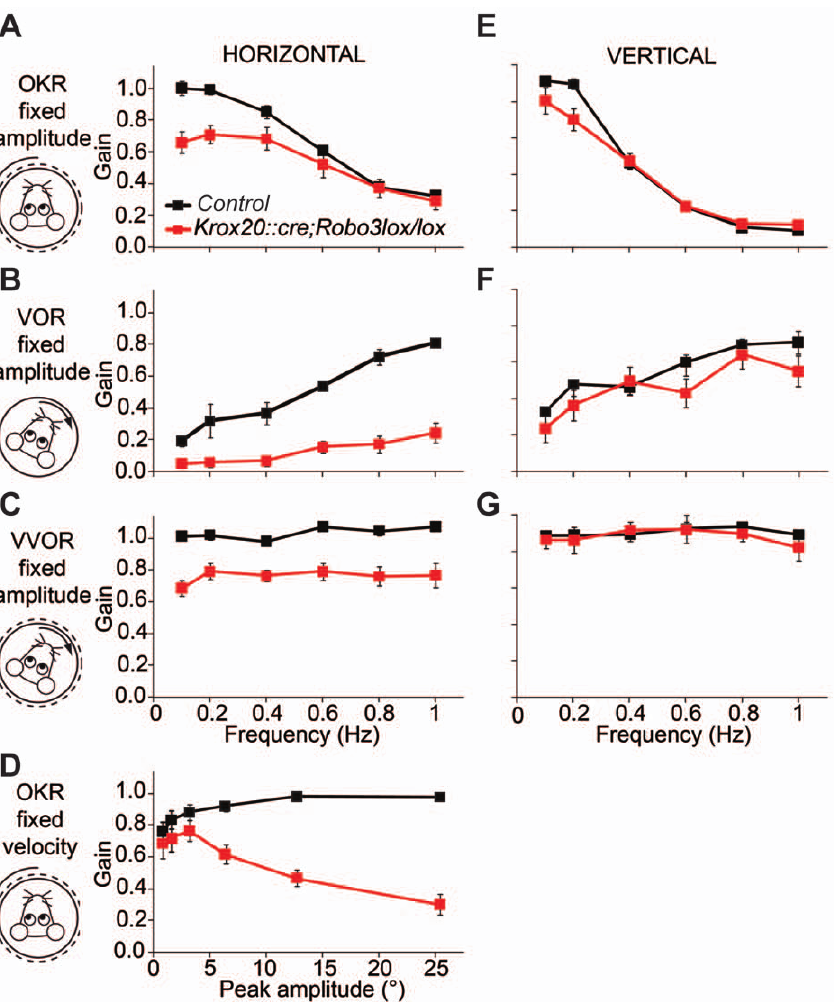
Figure 5. Impaired horizontal compensatory eye movements in Krox20::cre;Robo3 lox/lox mice. (A) During optokinetic stimulation horizontal gains are reduced most prominently at the lower frequencies in in Krox20::cre;Robo3 lox/lox mice ( p =0.043 ANOVA; n =6 versus n =4 for controls; see Table S1). (B) At higher frequencies, the VOR is severely impaired ( p =0.001 versus control mice curve; ANOVA for repeated measurements; Table S1), confirming the importance of the commissural connections in large-amplitude eye movements. (C) When horizontal visual and vestibular inputs are combined in the VVOR (visual vestibulo-ocular reflex), it results in lower gains over the entire range of frequencies tested ( p =0.004 versus control mice curve; ANOVA for repeated measurements). (D) OKR deficits are strongly correlated to the amplitude of stimulation. (E–G) In marked contrast, in the vertical plane, no significant differences were observed in OKR (E), VOR (F), or VVOR (G), supporting the concept that primarily horizontal eye movements require the presence of commissural connections (see Table S1 for all statistics). Error bars indicate standard error of the mean. Results were obtained from four control and six Krox20::cre;Robo3 lox/lox mice .